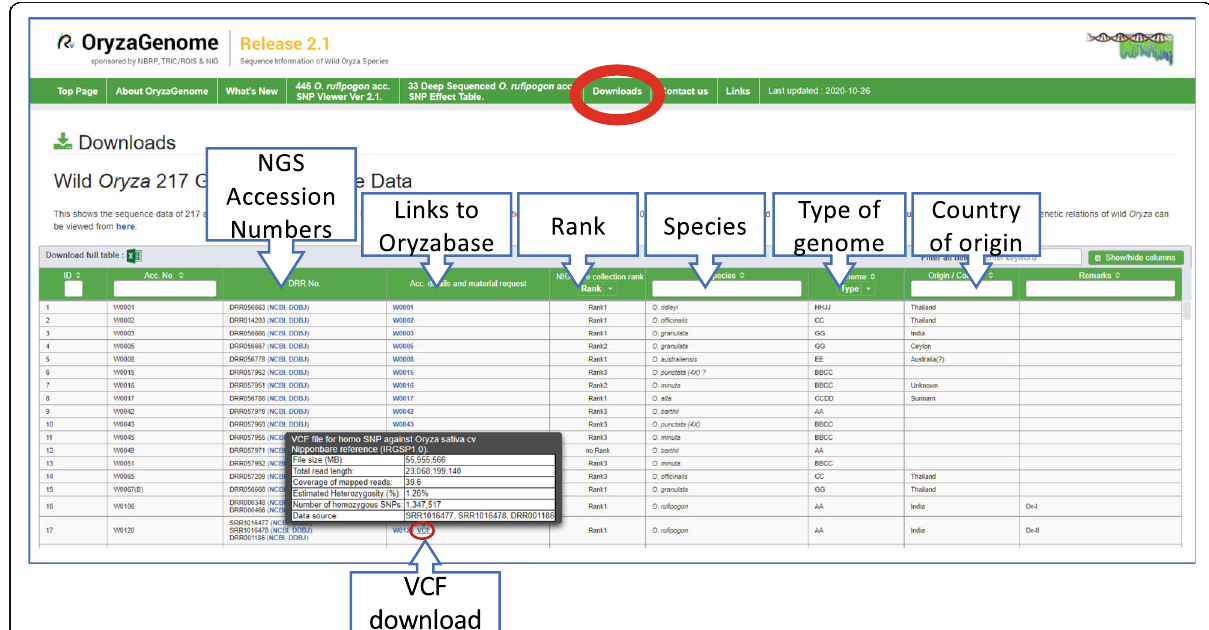
Fig. 1 Downloads page. Information on 217 wild Oryza genotypes can be searched by using the conditions in multiple columns. Information on the 33 Deep-sequenced O. rufipogon Accessions can be also obtained from this